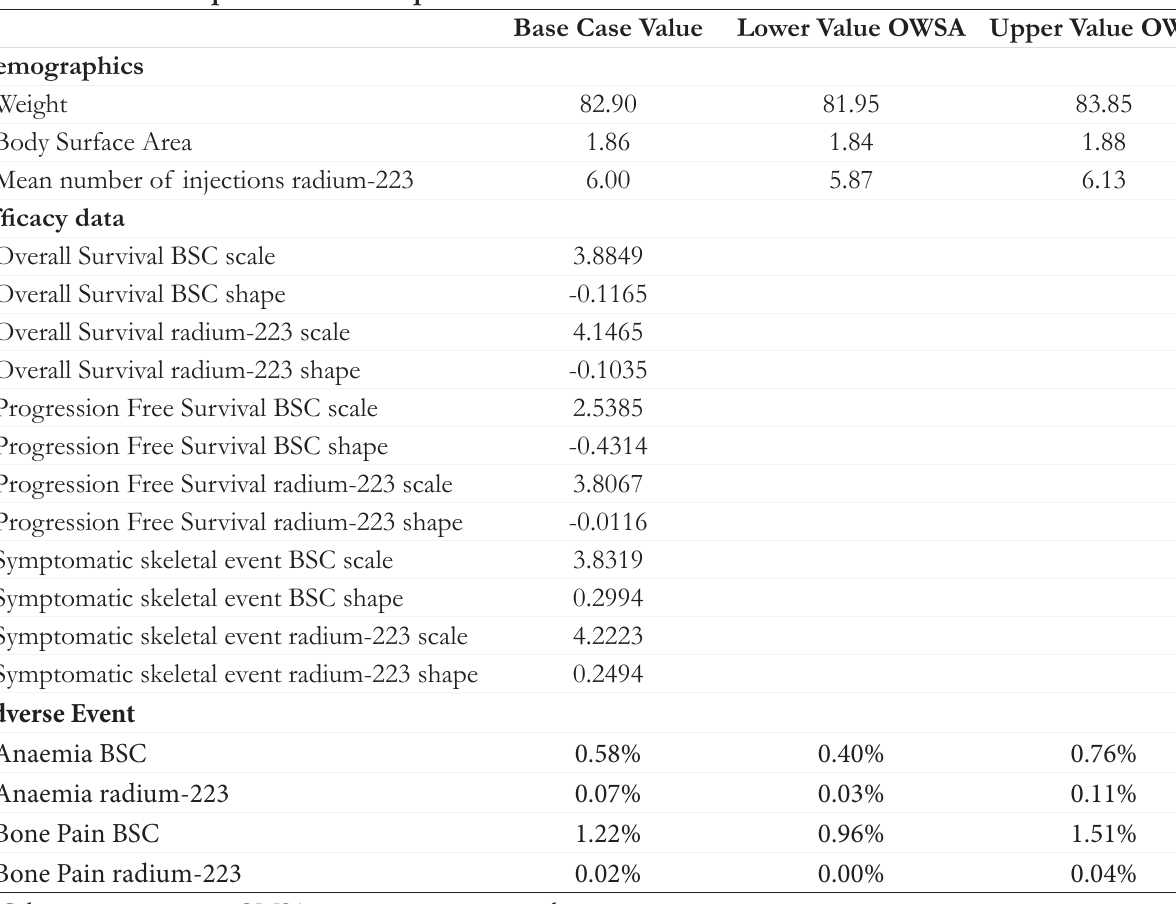
Table 1. Clinical Inputs Used to Populate the